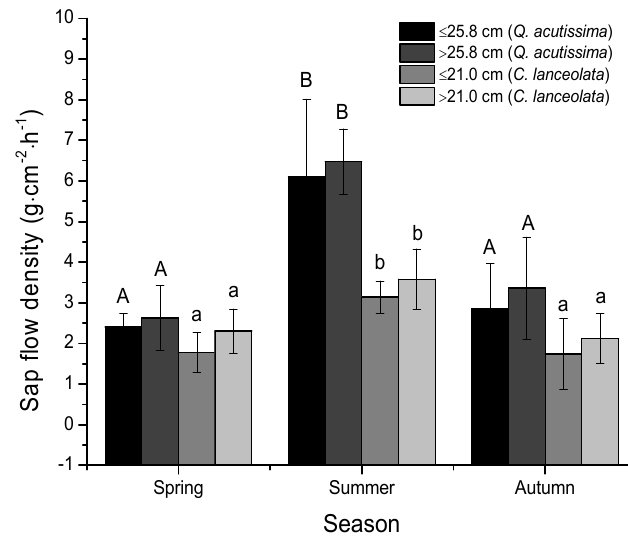
Figure 4. Values of sap flow density (g · cm –2 · h –1 ) for each DBH class for four seasons. Error bars show 95% confidence intervals. Vertical columns with the same uppercase ( Q. acutissima ) or lowercase ( C. lanceolata ) letters are not significantly different from each other at p < 0.05 according to the Tukey tests.